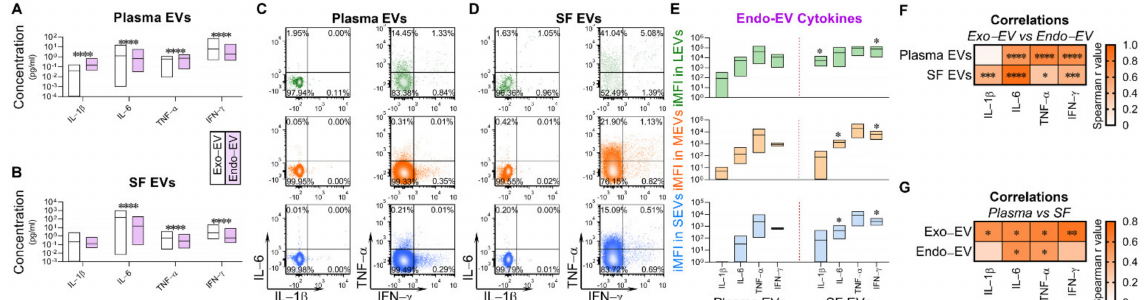
Figure 4. Exo-EV and endo-EV cytokines generally correlated in plasma and SF. ( A , B ) The concentrations of exo-EV and endo-EV cytokines in plasma and SF of OA participants were measured by multiplex immunoassay. The floating bars (min to max with line at mean) represent the differential concentrations between exo-EV and endo-EV cytokines in plasma ( A ), n = 46) and SF ( B ), n = 48). Comparisons between the concentrations of the matched exo-EV and endo-EV cytokines were performed using Wilcoxon matched-pairs signed rank test with desired FDR q < 0.05, and the results are indicated as q value **** < 0.0001. ( C , D ) EVs from the matched plasma and SF of OA participants ( n = 8) were profiled for the indicated intra-vesicle cytokines by high-resolution multicolor flow cytometry. The graphics are representative color dot plots